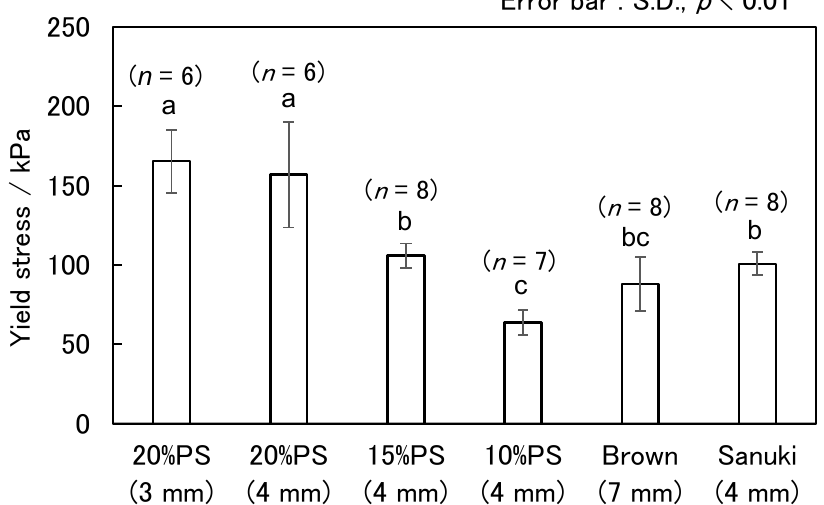
Figure 5. Stress–strain diagram of cooked rice noodles: a representative measurement of each con- dition. “ ≈” means “approximately equal”.